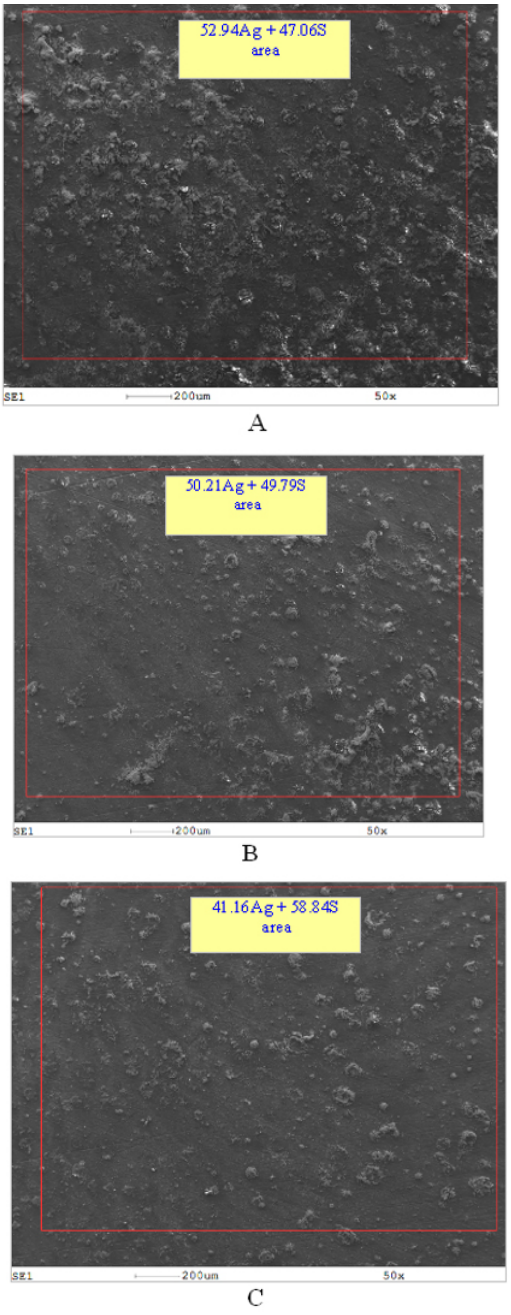
Figure 3. SEM micrographs of magnesium disk surface after cementation in 0.0025 M [Ag(S and content of silver and sulfur at positions A, B and C.